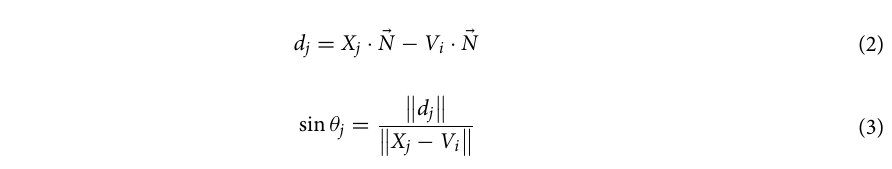
Figure 5. Geometric algorithm and analysis process. ( a ) Relationship between the normal vector through V i and adjacent vertices, X j , X j+1 , and X j+2 . ( b ) In calculation process, the pyramid with steep apex (blue) demonstrates larger sin θ j value compared to the pyramid with blunt apex (yellow). As a result, sin θ ′ j > sin θ ′′ j . ( c ) The distribution of vertices according to curvature is shown before and after surgery using the Gnuplot Library. The purple bars indicate the preoperative data, and the green bars indicate the postoperative